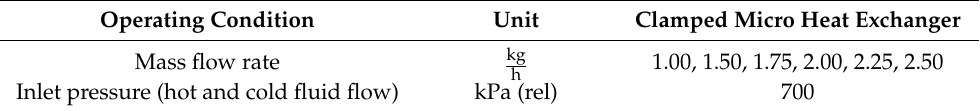
Table 5. Operating conditions for the clamped microstructure heat exchanger examined with air.